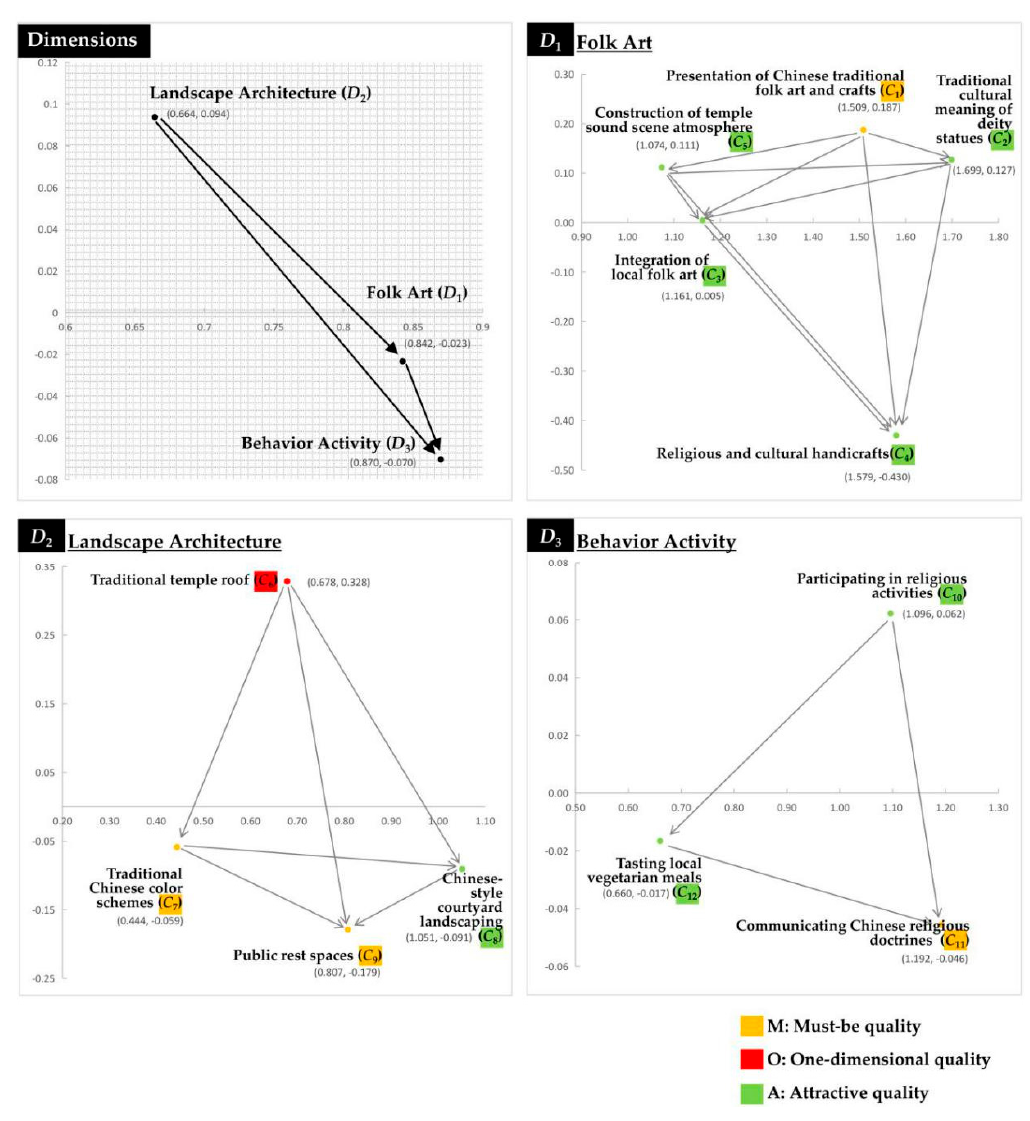
Figure 6. The influence network relation map.